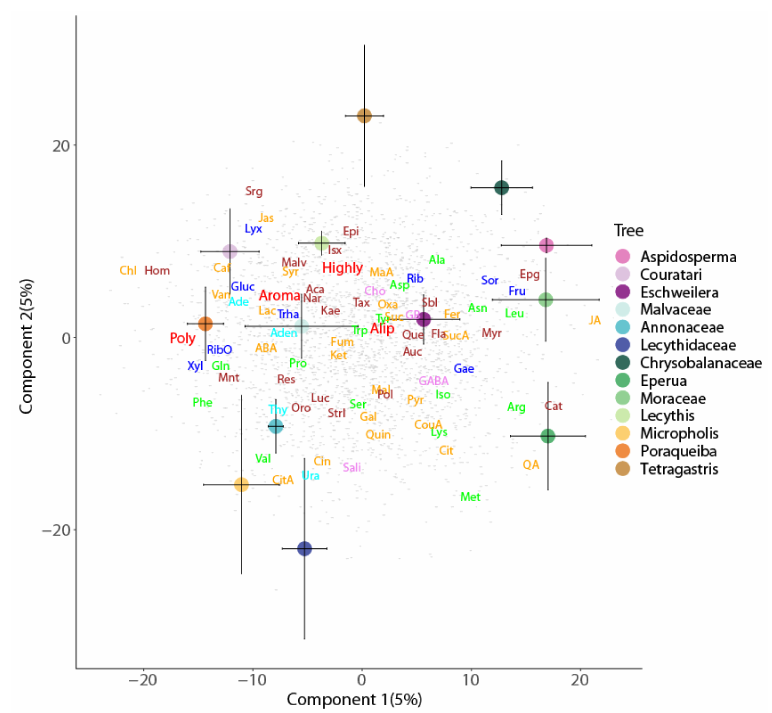
Figure 2. Partial least squares discriminant analysis biplots of metabolomic profiles of forest floor and suspended soils across 13 species of tree (Table 2). Depicted values are means ( ± 95% CI). Metabolites as in Figure 1.